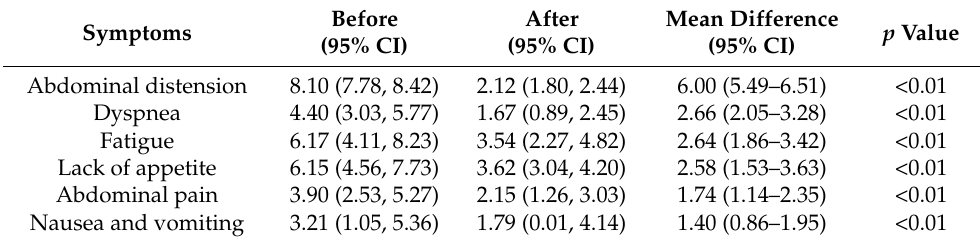
Table 2. Effect of CART on the alleviation of symptoms using a numerical rating scale system (0–